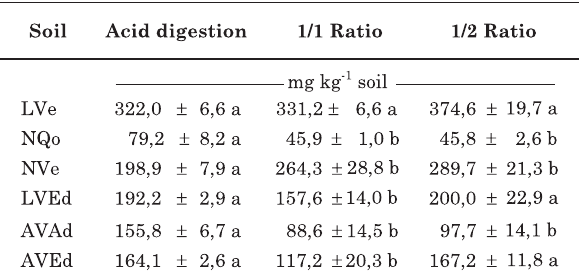
Table 10. Total S by alkaline oxidation using the Eschka mixture (ratios of 1/1 and 1/2) at 800 °C for 1 h (n = 4)